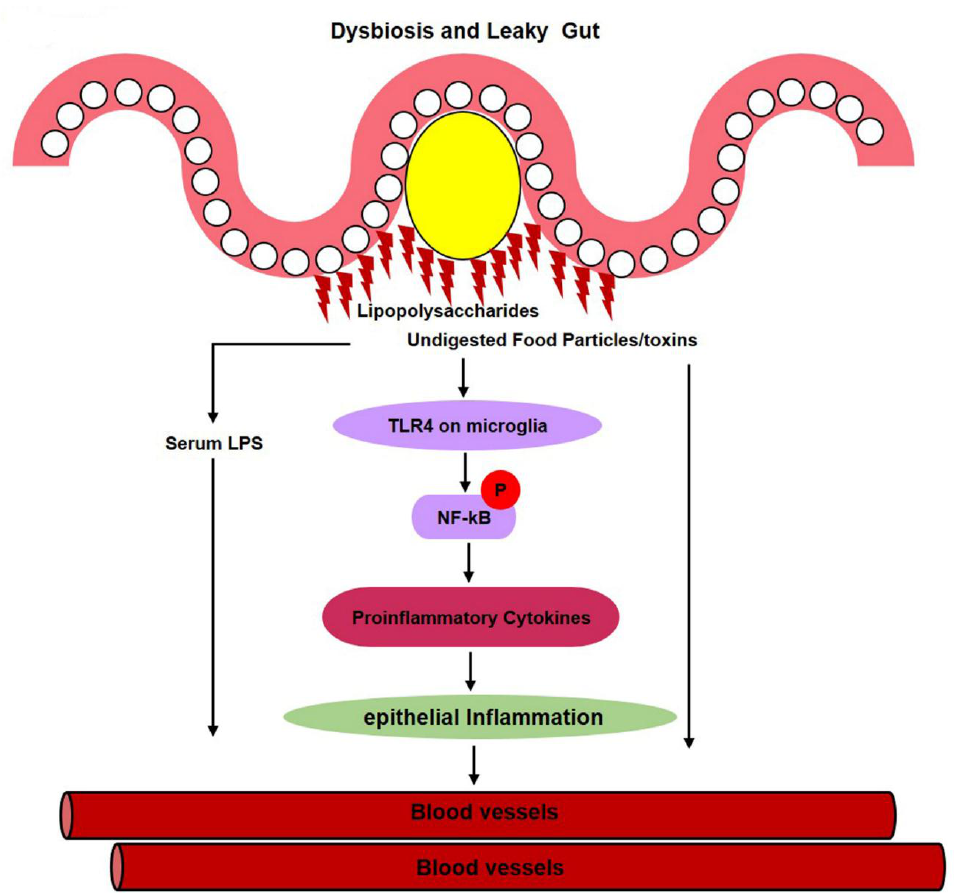
Figure 5. Gut dysbiosis causes epithelial inflammation. When harmful, particularly E. coli , Gram- negative bacteria secrete lipopolysaccharides that activate the TLR4 pathway and later on cause intestinal-wall and epithelial inflammation. This lipopolysaccharide not only activates the TLR4 signaling pathway, but also microglial and astrocyte cells in the gut, that then secrete proinflammatory cytokines. These proinflammatory cytokines later gain entry to the bloodstream via